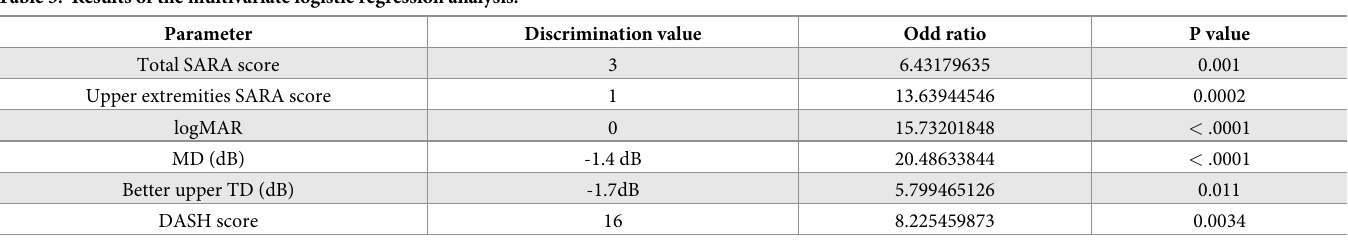
Table 3. Results of the multivariate logistic regression analysis.